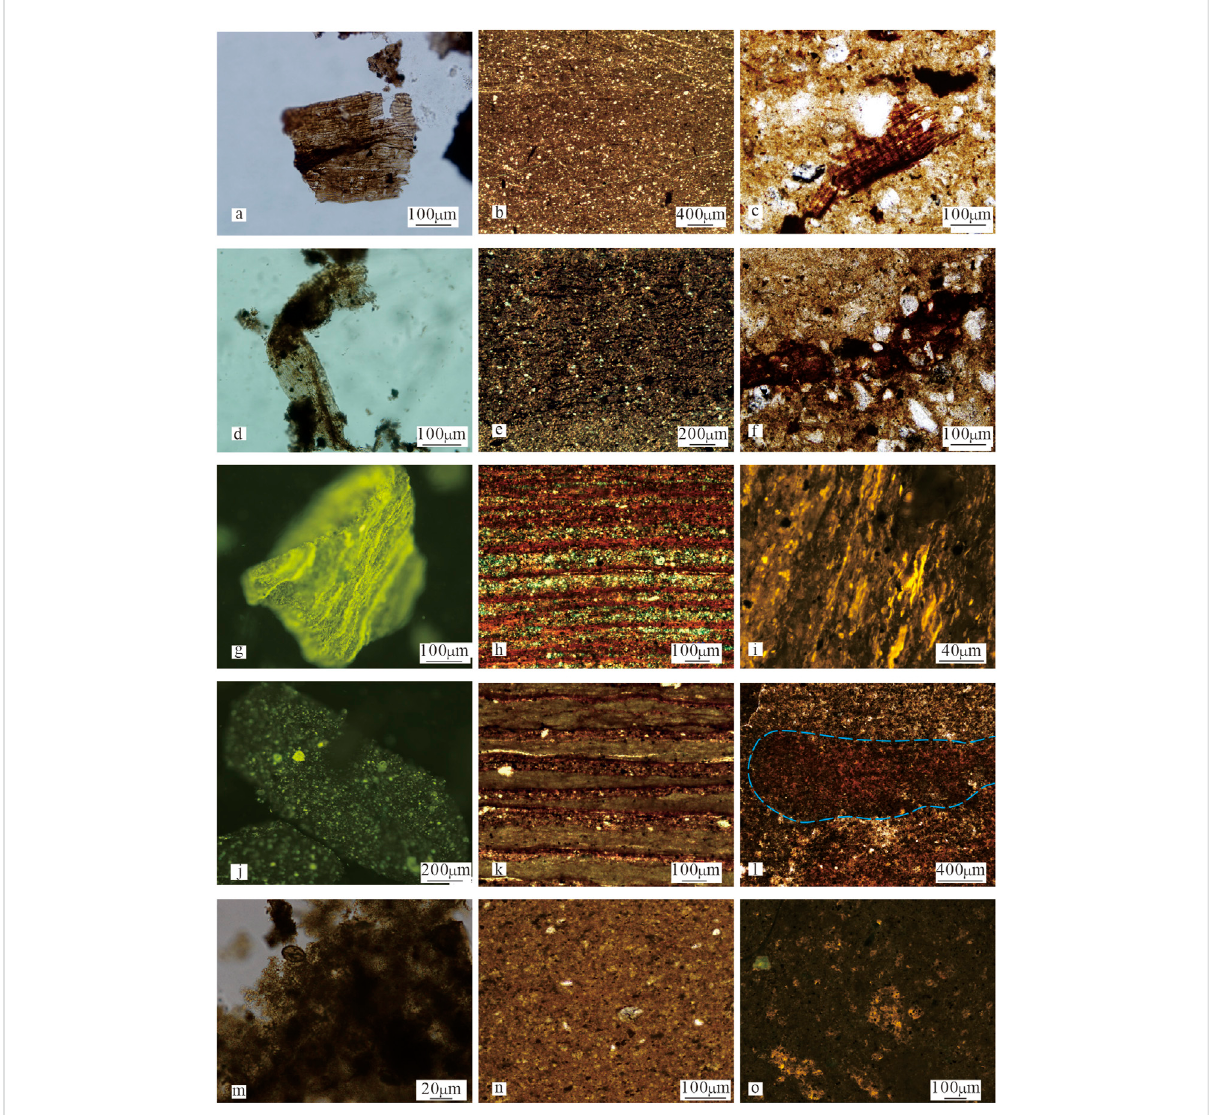
FIGURE 6 OM preserved in rocks. (A) . Land plant tissue fragments; (B) . vertical section of mudstone rich in land plant fragments; (C) . land plant fragments visible in a cross-section of mudstone (A – B) . N38, 2951.5 m, middle Es3 submember); (D) . macrophyte fragments; (E) . discontinuous laminae in mudstone rich in macrophytes (vertical section); (F) . preserved macrophyte fragments in a cross-section of mudstones (d-f. N38, 3336.6 m, lower Es3 submember); (G) . laminated AOM; (H) . shales rich in laminated AOM that contain abundant OM-rich laminae; (I) . granular AOM visible in a cross-section of shales under fl uorescent light ( G – I . NY1, 3375.3 m, upper Es4 submember); (J) . granular AOM; (K) . shales rich in granular AOM characterized by a laminated structure; (J) . granular AOM particles in a mudrock cross-section (within the dotted blue line) ( J – L . NY1, 3357.3